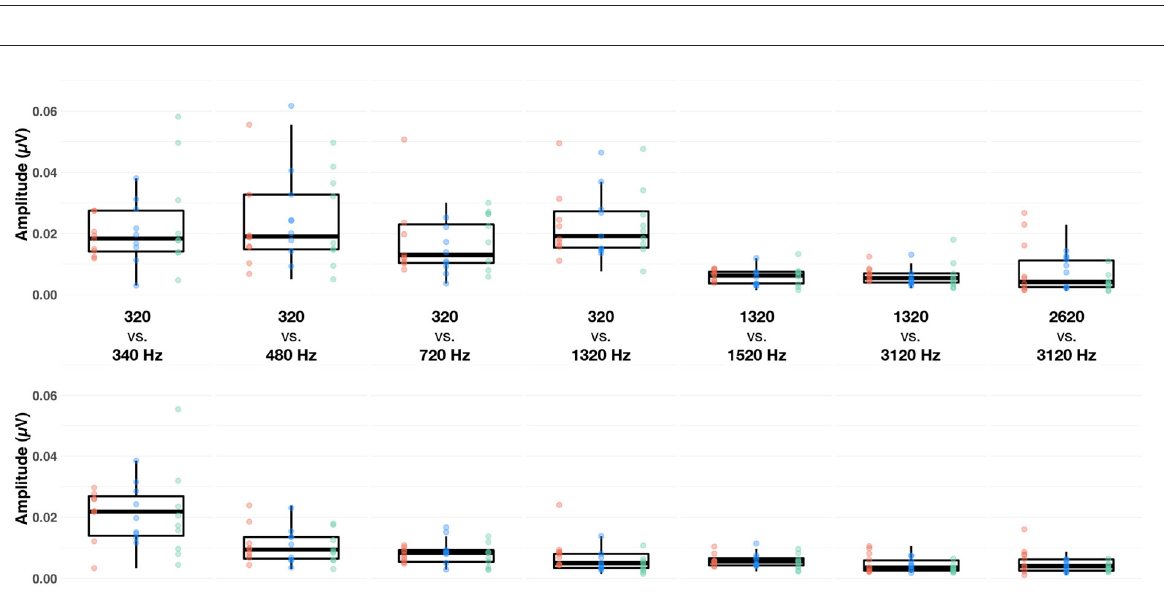
FIGURE3 Boxplots of baseline-corrected amplitude ( µ V) of the subcortical response evoked by the F0 (upper row) and F0 ′ (lower row) in each of the seven conditions (columns), at fast (red dots), medium (blue dots) and slow (green dots) alternating rates, recorded at Cz. The whiskers indicate values that fall within 1.5 times the interquartile range. Dots falling outside the whiskers are